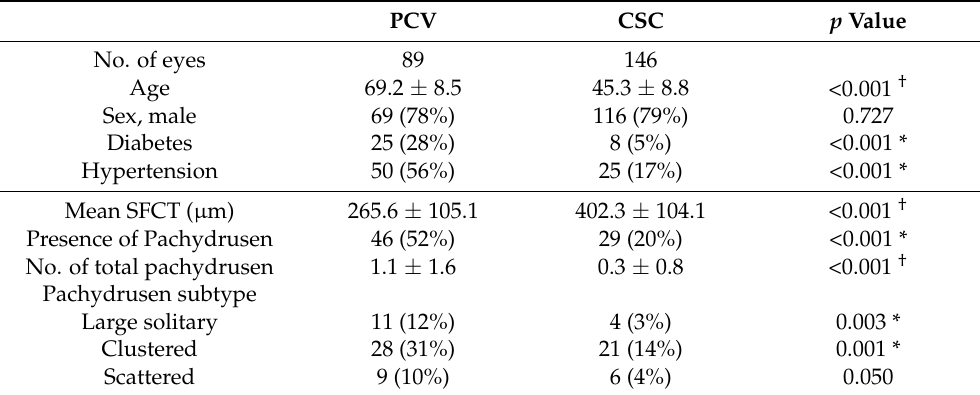
Table 1. Baseline characteristics and OCT-related factors of included patients. PCV CSC p Value No. of eyes